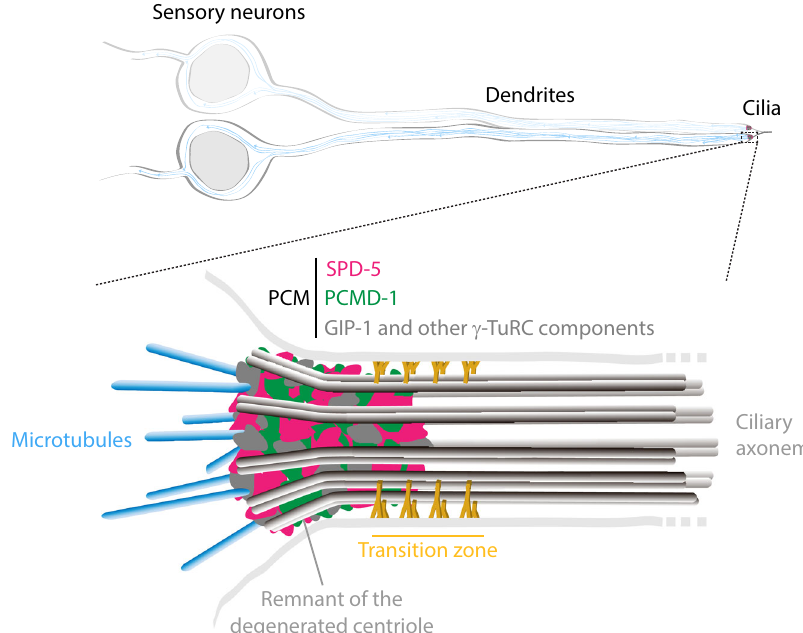
Fig. 1 A matrix of SPD-5 and PCMD-1 scaffolding proteins form the PCM of centrosomes in C. elegans sensory neurons. This centrosomal PCM persists after centriole degeneration and continues to anchor γ -TuRCs to maintain the centrosome ’ s MTOC